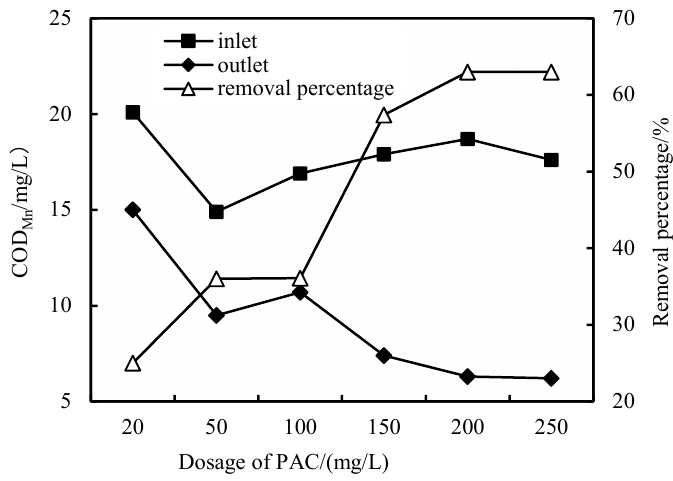
Figure 5. Removal effect of COD Mn with PAC dosage.